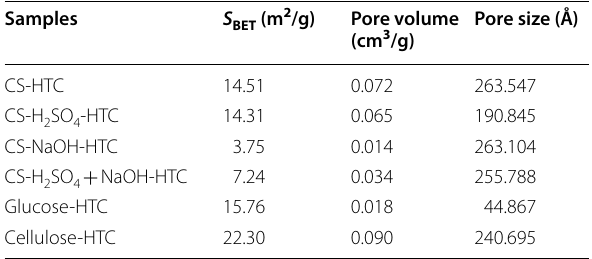
Table 2 BET surface area, pore volume and pore size of CS, glucose and cellulose-derived hydrochars Samples